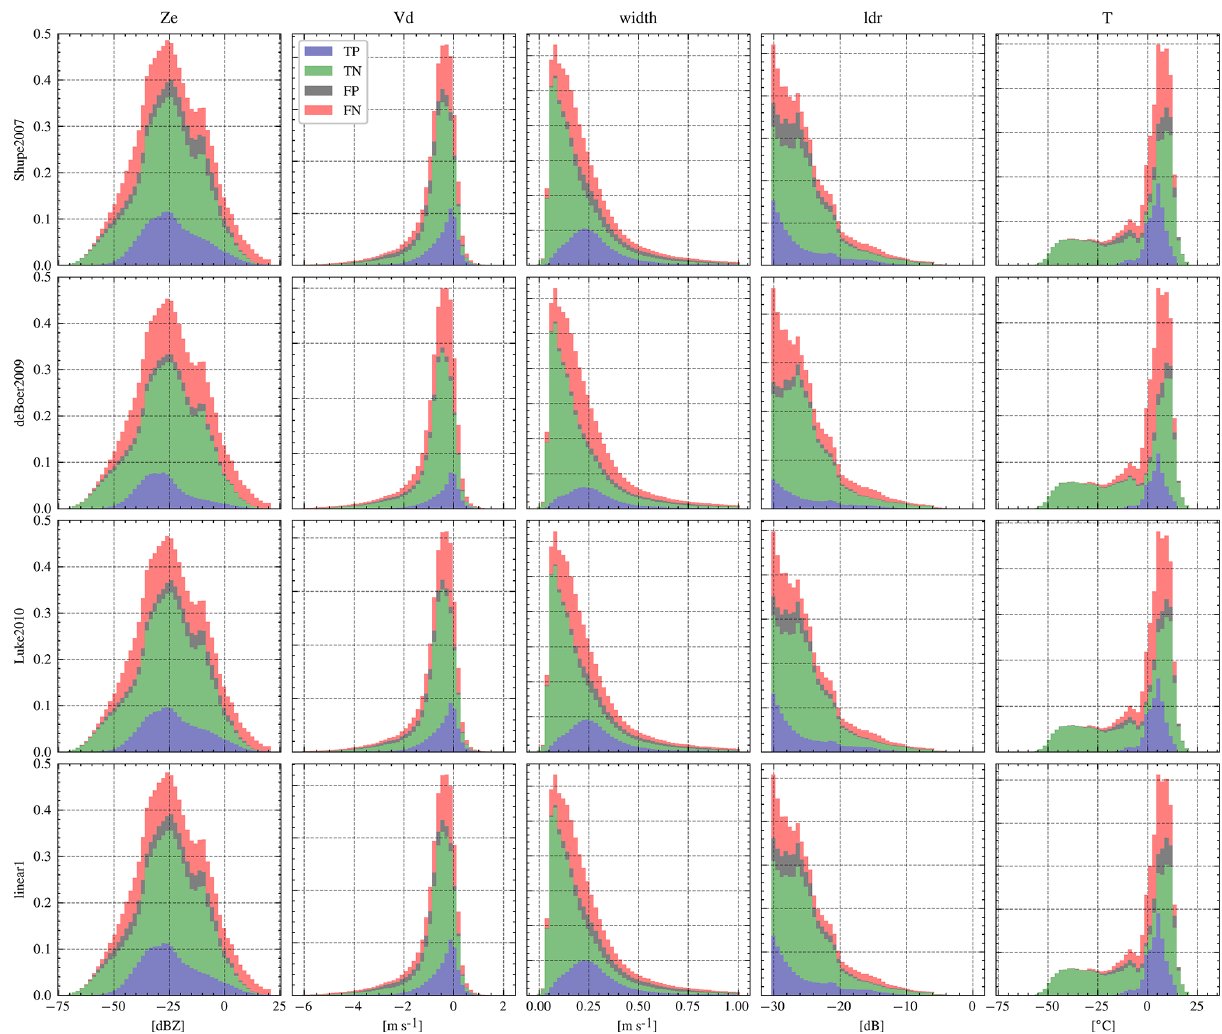
Figure A3. Relative frequency of occurrence plots of radar moment reflectivity ( Z e , left column), mean Doppler velocity ( V d , second left column), spectrum width (middle column), linear depolarization ratio (LDR, second to right column), and environmental temperature T (right column) of ANN liquid-prediction error matrix elements TP (blue), TN (green), FP (grey), and FN (red) for the four utilized ANN- lidar variable thresholds of Shupe2007 (first row), deBoer2009 (second row), Luke2010 (third row), and linear-1 threshold (fourth row) for the entire ACCEPT field